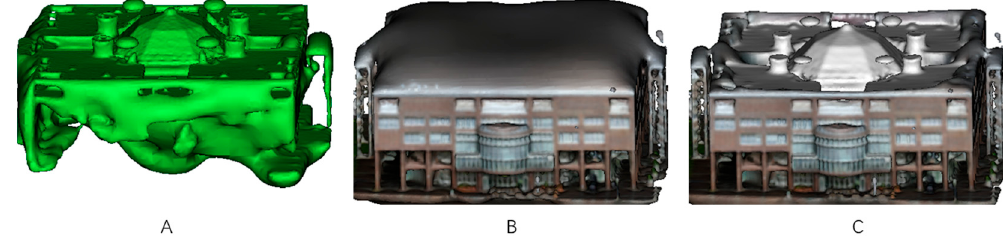
Figure 8. Poisson surface reconstruction results from: ( A ) open LiDAR data. ( B ) a façade point cloud generated from ground images. ( C ) the fusion point cloud of open LiDAR data and the façade point cloud.